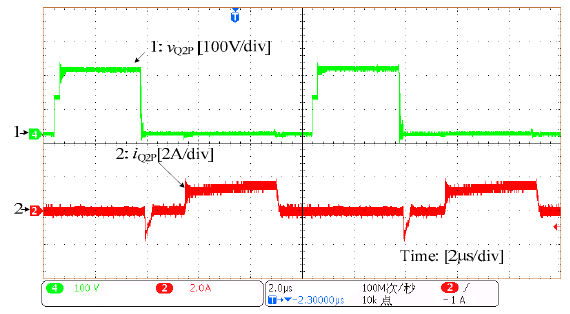
Figure 9. Waveform of v Do 1 .